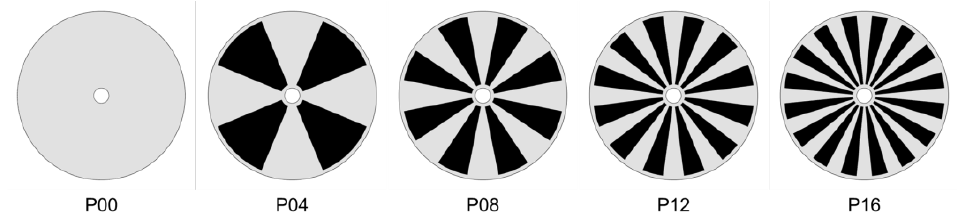
Figure 2. The five disks used in this study with the number of patterns N p = 0, 4, 8, 12, and 16, which are denoted by P00, P04, P08, P12, and P16, respectively. In each patterned disk, engraved areas are filled with the black color. In the cases of patterned disks, the pattern depth is 1.25 mm.